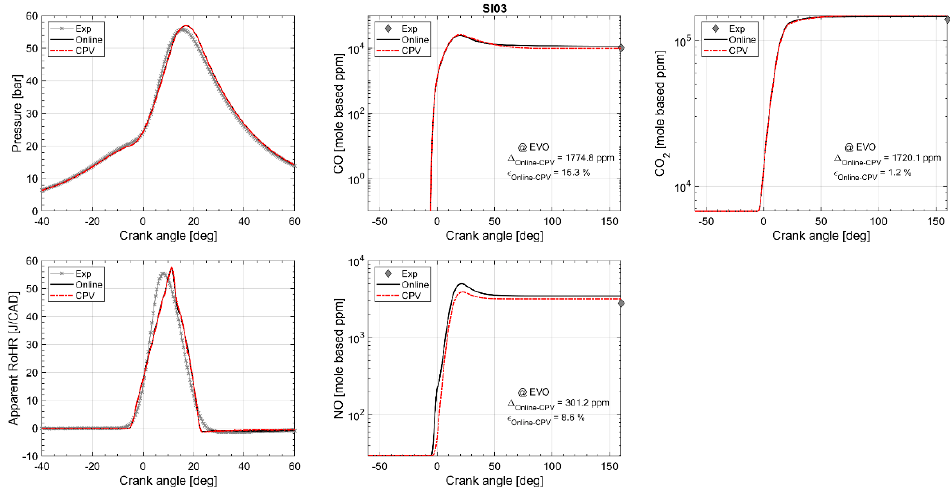
Figure A13. Engine performance and emissions for operating point SI03 (2000 rpm, 10.0 bar IMEP).